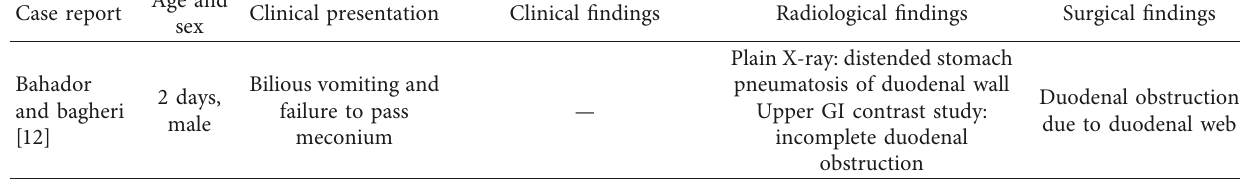
Table 1: Comparison of the present case with reported cases of gastroduodenal emphysema due to congenial duodenal web. Case